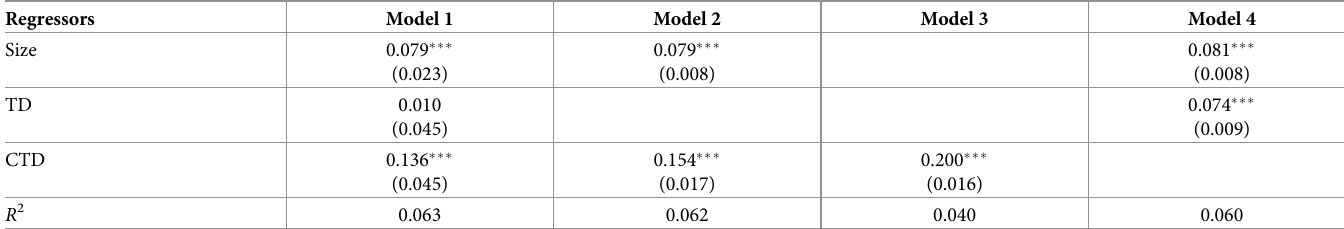
Table 1. Statistical significance of the Coherent Technological